Question: Identify the chart type used in this figure.
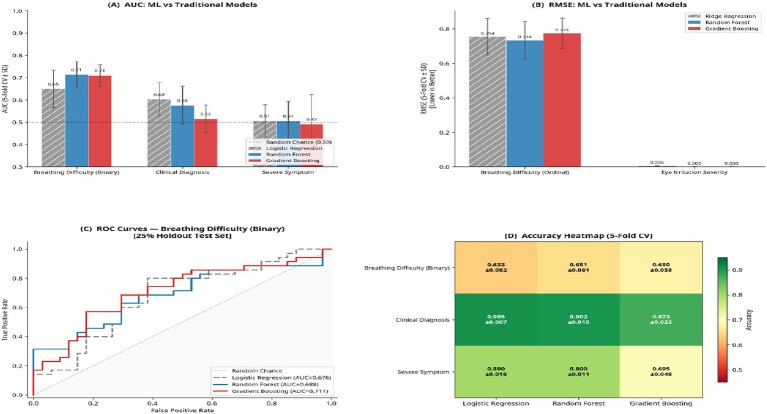
Answer: heatmap